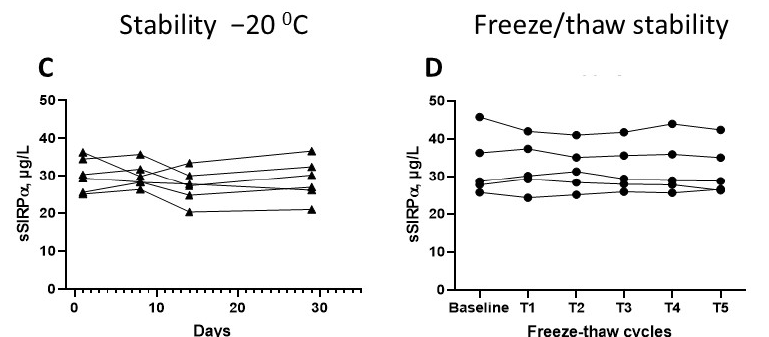
Figure 4. ( A ) Whole blood samples stored at room temperature or 4 °C were stable for up to 24 h before centrifugation. ( B ) Pipetted serum samples were stable at 4 °C for up to 8 days and underwent a small reduction in concentration between days 8 and 14 ( p = 0.0313), * p < 0.05. ( C ) Pipetted serum samples were stable at − 20 °C for up to 29 days ( p = 0.3125). ( D ) Concentration of sSIRP α in pipetted serum was unaffected for at least five freeze–thaw cycles at − 80 °C ( p = 0.5347).